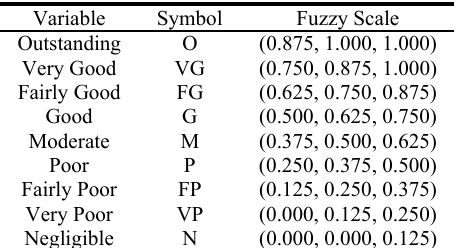
Table 2. Linguistic variables for rating